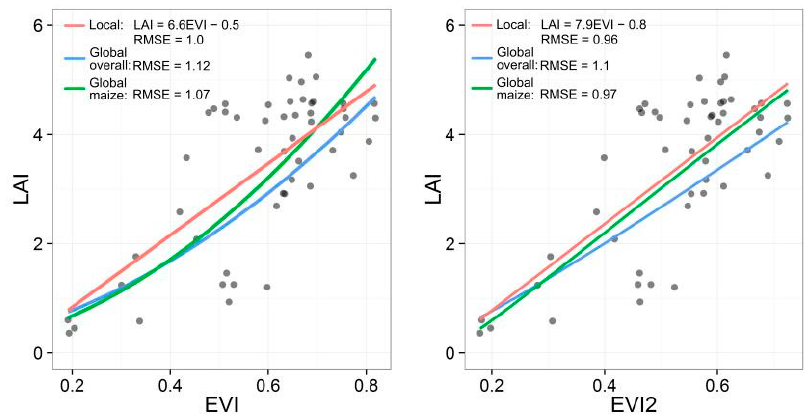
Figure 9. Comparison between global overall, global maize LAI-VI relationships, and local LAI-VI relationships for the maize fields in Wisconsin. The VIs were calculated based on images collected by the air-borne sensor.